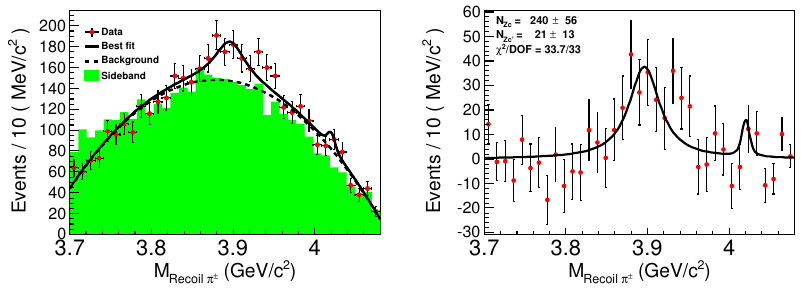
√ s = 4 . 23 GeV and the fit with